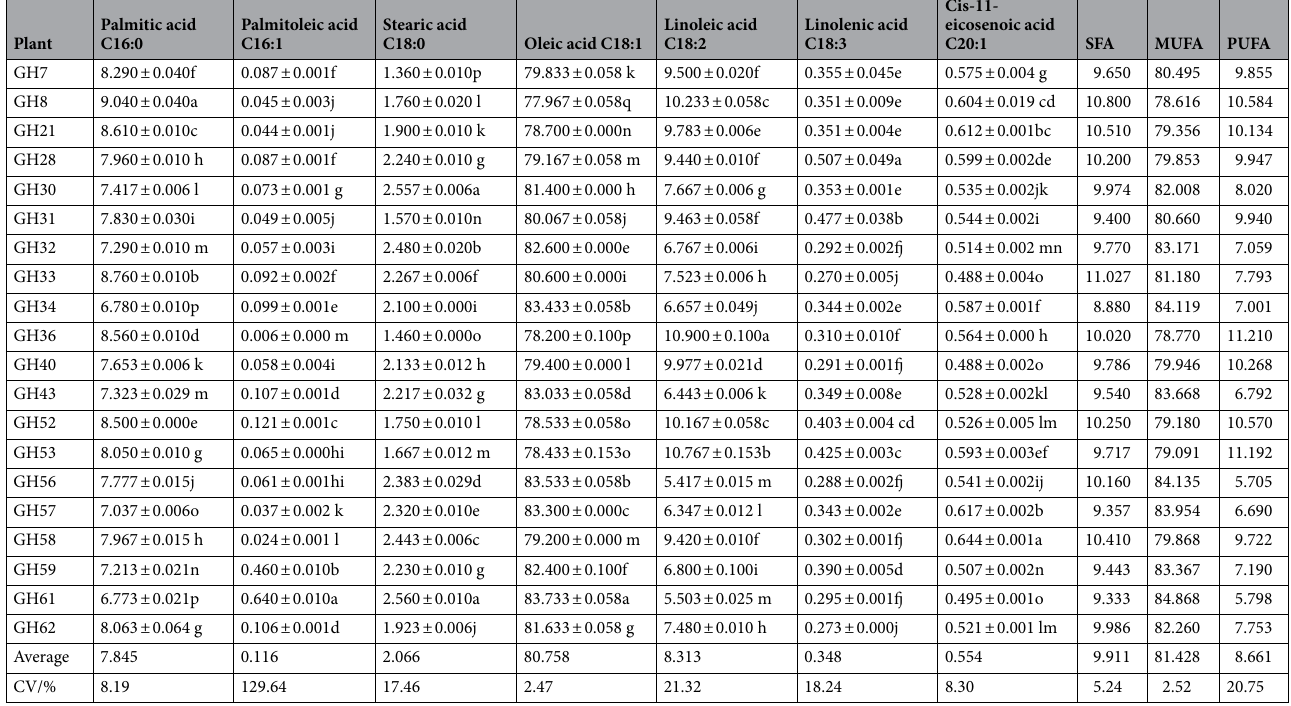
Table 2. Fatty acid components in the seed oil of 20 Wangmo red ball Camellia oleifera germplasms. The data in the table are the mean ± standard deviation; the same letters in the same line indicate no significant difference ( P > 0.05), while different lowercase letters in the same line indicate a significant difference ( P < 0.05). CV: coefficient of